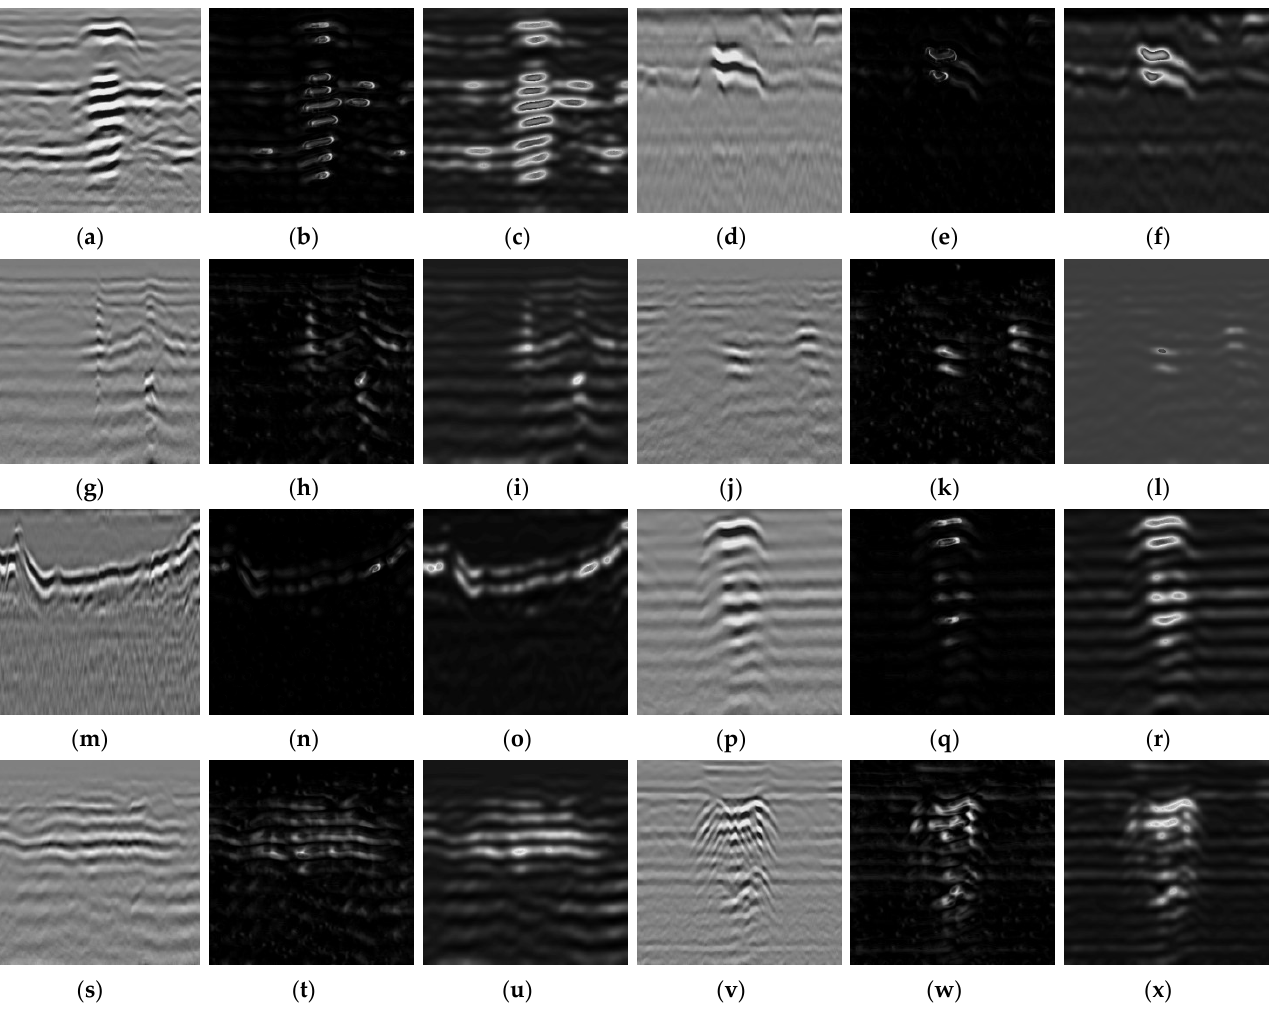
Figure 10. Brightness and directional visual features: ( a , d , g , j , m , p , s , v ) are the filtered GPR image 1 to filtered GPR image 8; ( b , e , h , k , n , q , t , w ) are the direction feature of image 1 to image 8; ( c , f , i , l , o , r , u , x ) are the brightness feature of image 1 to image 8. For the brightness and directional features extracted above, linearly combine them according to Formula (10) and construct these abnormal significant regions of the GPR image shown in the second column and the fourth column of Figure 11. In the visual significant regions, the importance of the corresponding area from white to black de- creases in turn, and the probability of the area being abnormal also decreases step by step.